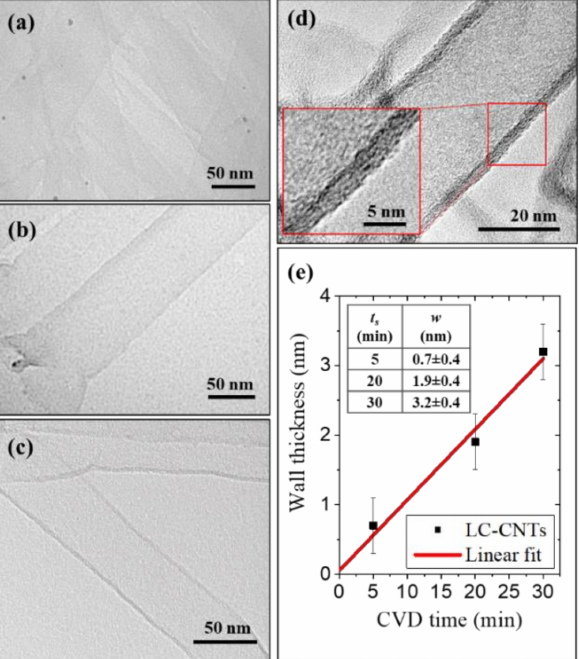
Figure 2. TEM micrographs of LC-CNTs growth with 25 sccm C 2 H 2 flow at ( a ) 5 min, ( b ) 20 min, and ( c ) 30 min of synthesis time. ( d ) HR-TEM micrograph of sample growth with 30 min of synthesis time. ( e ) Wall thickness as a function of the time synthesis plot obtained from the HR-TEM